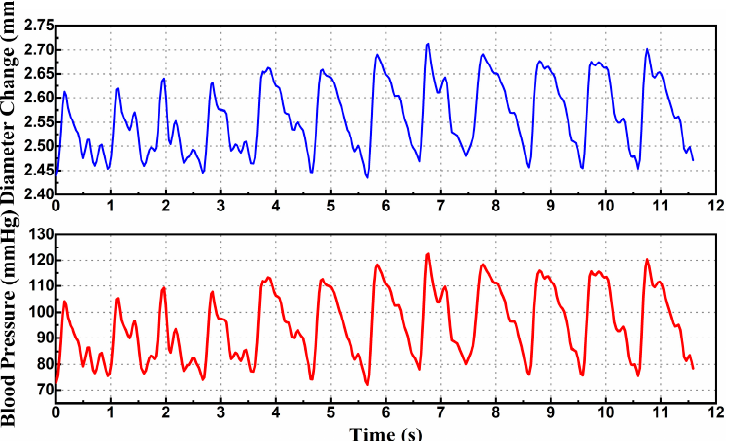
Figure 12. Continuous monitoring of radial artery diameter and estimated continuous beat-to-beat blood pressure. blood